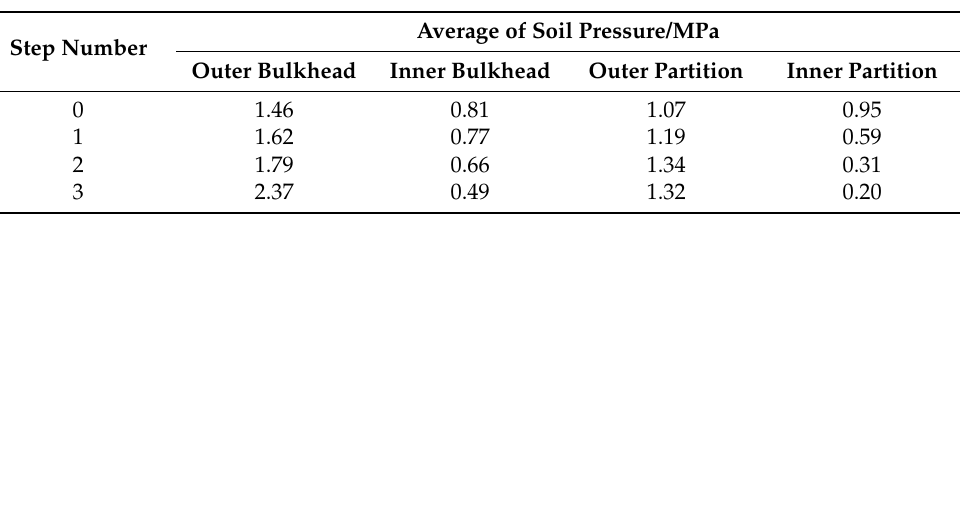
Table 3. Averages of the field soil pressure during soil excavation